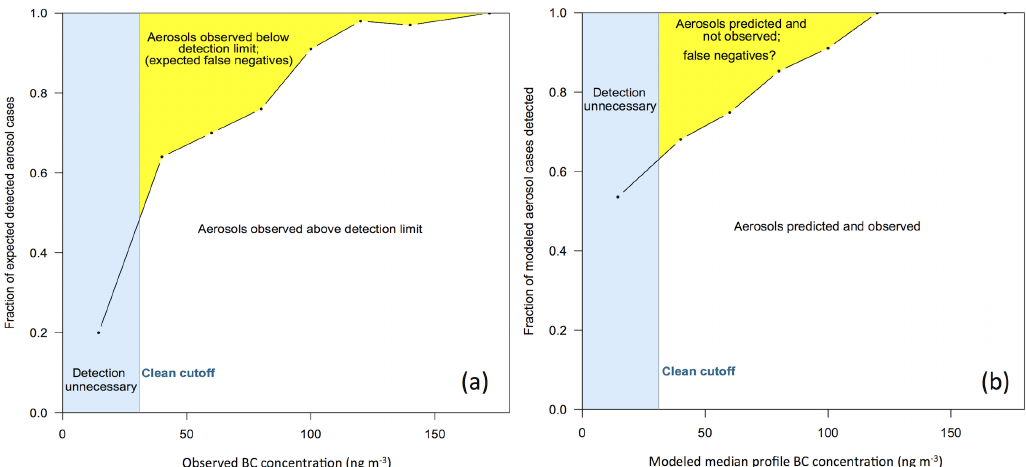
Figure 2. Based on CALIPSO Arctic profiles under non-cloudy conditions, we compare (a) the expected fraction and (b) possible maximum fraction of false negatives (aerosol present but not detected) for the combustion tracer black carbon (BC, ngCm − 3 ) . The expected fraction of false negatives in panel (a) was determined by comparing binned out-of-cloud 2008 ARCTAS-A and ARCTAS-B BC concentrations with the fraction of the total number of samples between 1 and 5km that had converted backscatter values (Mm − 1 sr − 1 ) above the CALIPSO clear-sky nighttime backscatter detection limit from Winker et al. (2009) (see text for more details). Possible maximum false negative values in panel (b) were determined by comparing the FLEXPART model’s median BC concentrations between 0 and 10km with the fraction of the total CALIPSO profiles under non-cloudy conditions during January 2008 where aerosols were not detected. The clean cutoff below which air is taken as clean is assumed to be 30ngBCm − 3